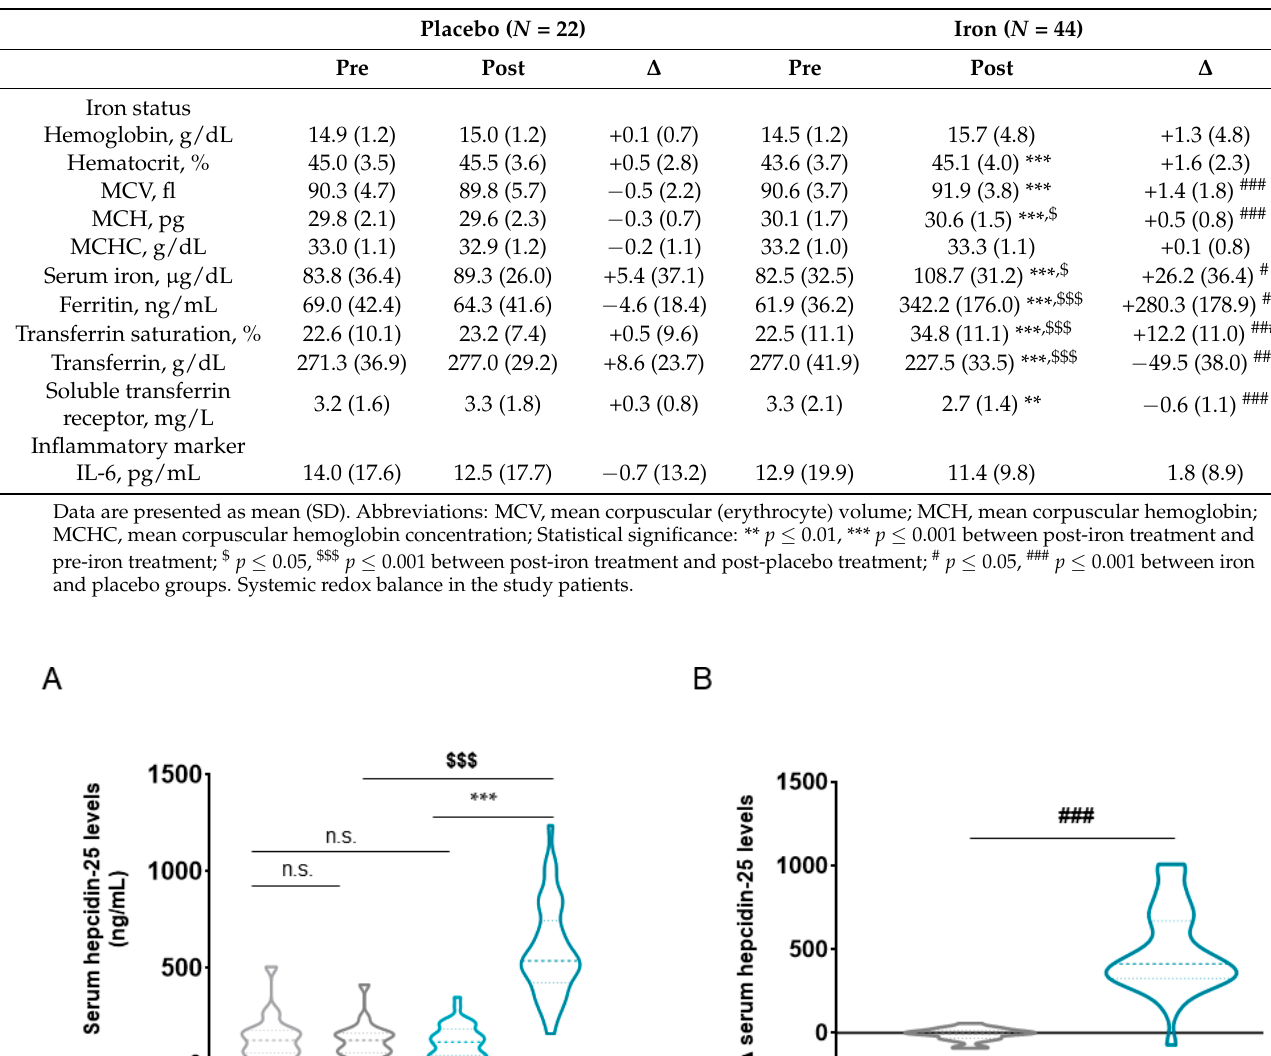
Table 2. Iron metabolism and inflammatory parameters of the study patients at baseline and after treatment.